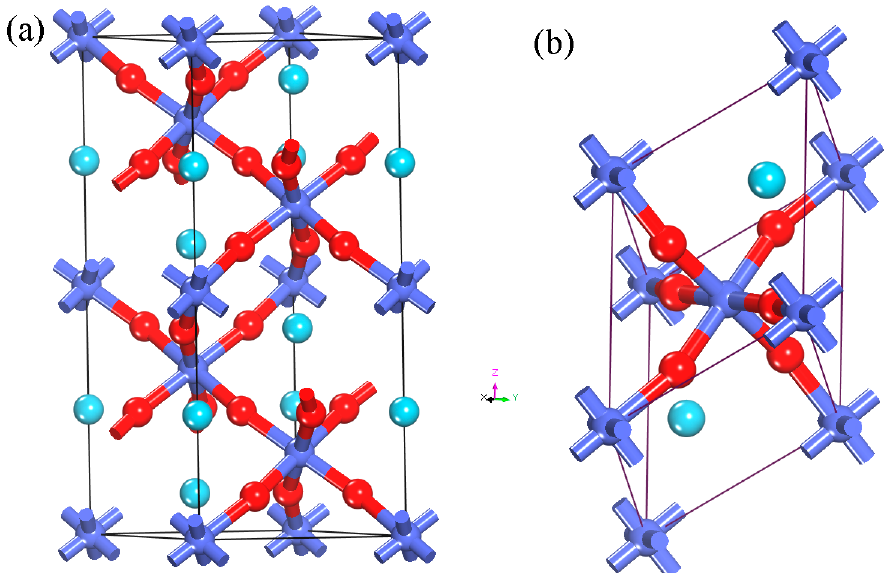
Figure 1. Schematic unit cell ( a ) and primitive cell ( b ) of LaCoO 3 . La atoms are shown in wathet blue, Co atoms in blue and O atoms in red. (For interpretation of the references to color in this figure caption, the reader is referred to the web version of this article).